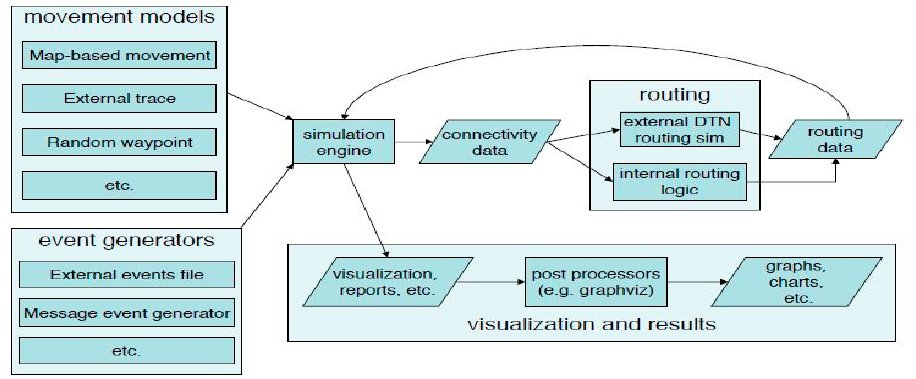
Figure 1. Overview of the ONE simulator [6].